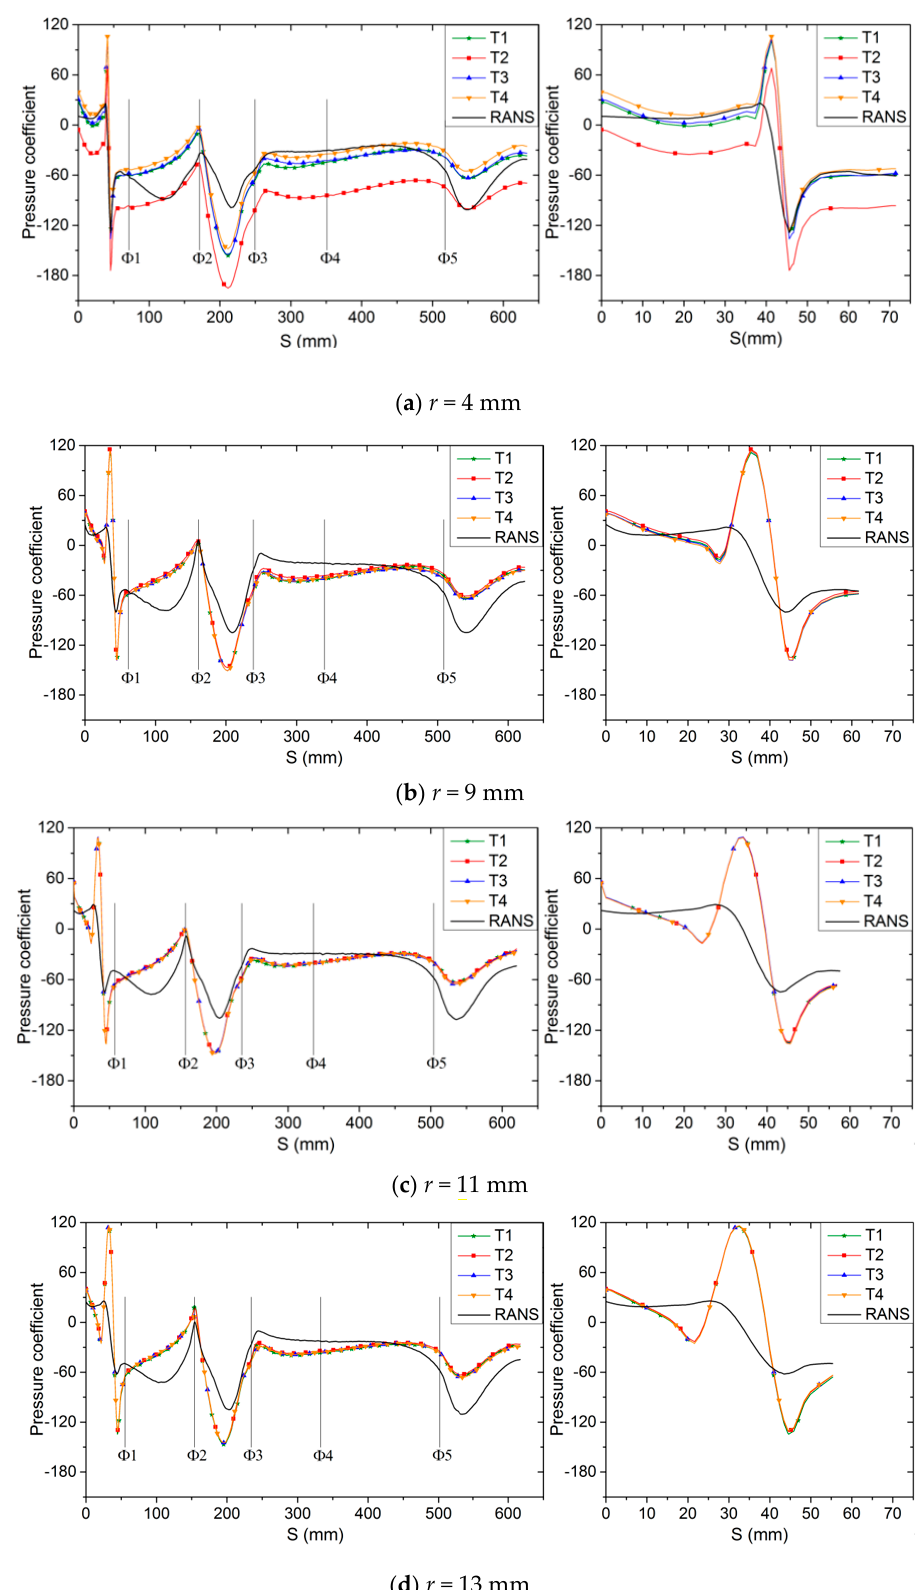
Figure 17. Distribution of pressure coefficient around the volute surface (left column) and the enlarged view around the volute tongue (right column) on the Z = 4 mm cross-section.